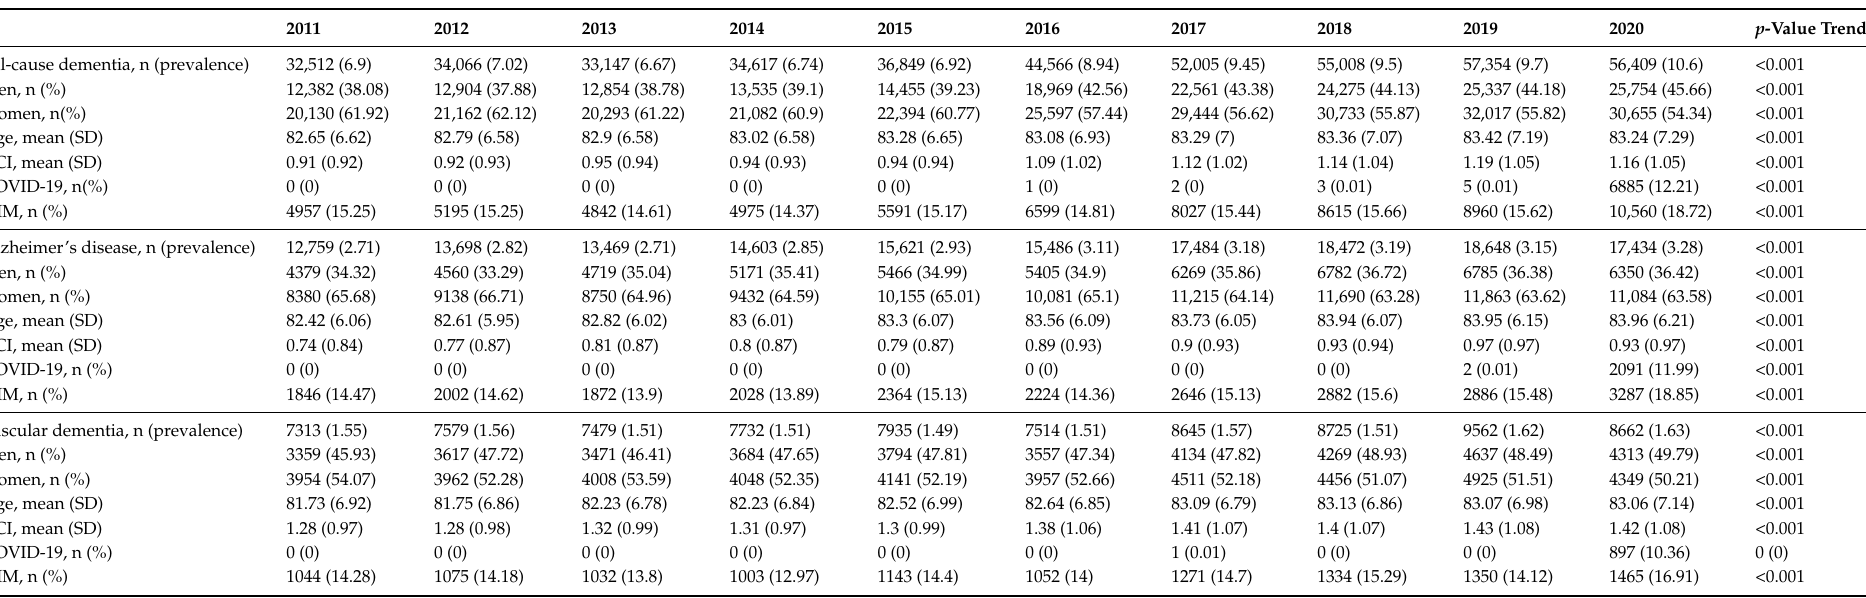
Table 1. Characteristics of the patients hospitalized with type 2 diabetes and suffering from concomitant all-cause dementia, Alzheimer’s disease and, vascular dementia according to year (2011–2020).